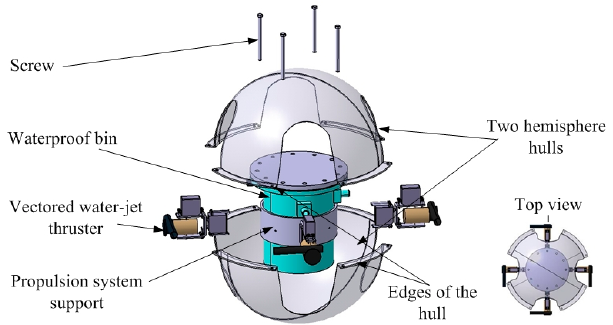
Figure 9. 3D model of SURIII.